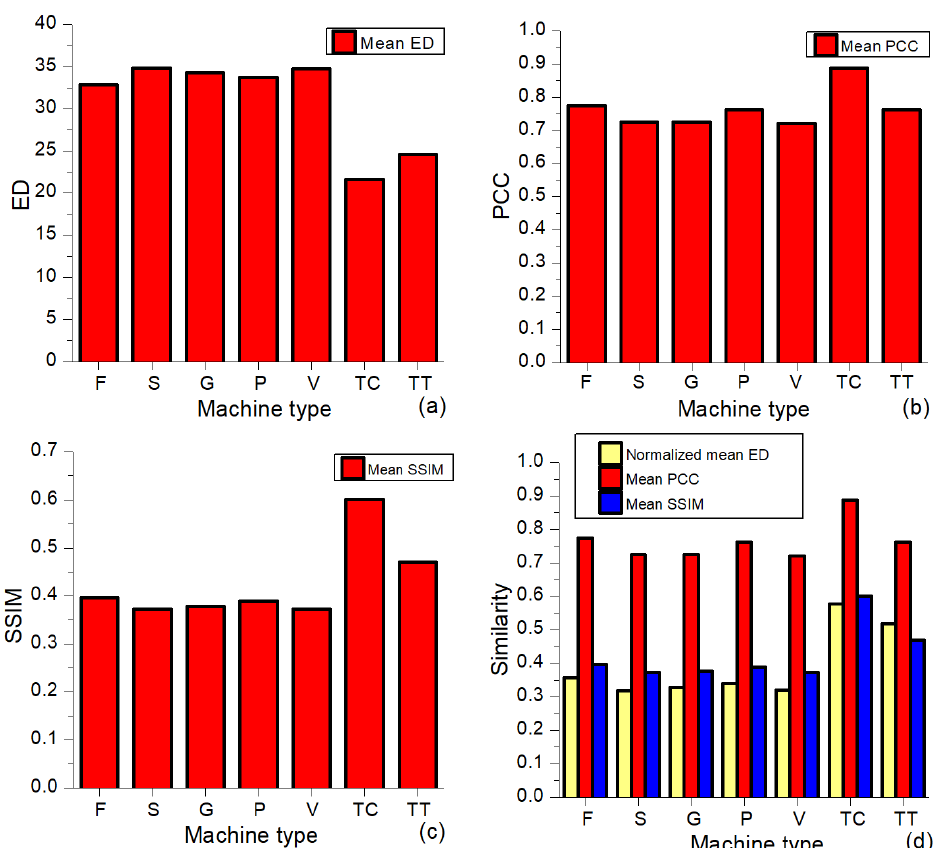
Figure 2. Mean values of intraclass similarity for the full dataset: ( a ) ED, ( b ) PCC, and ( c ) SSIM, as well as ( d ) normalized ED, PCC, and SSIM together; F is used for fan, S for slider, G for gearbox, P for pump, V for valve, TC for toy-car, and TT for toy-train.